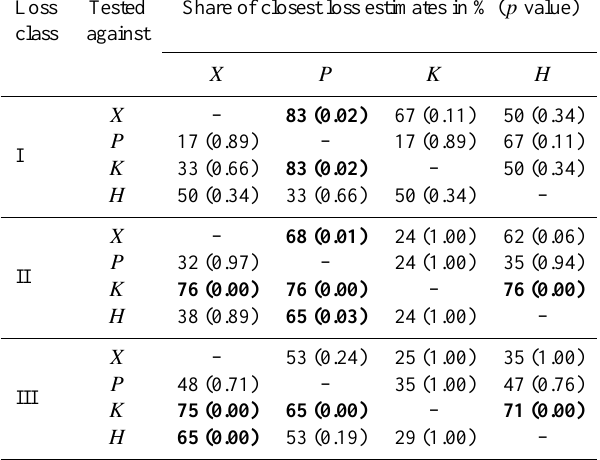
Table 3. Results from a binomial test for prediction accuracy of the different models based on daily loss estimates calculated from DWD wind gust data. The model of each column is tested against each row of competing models and across loss classes (as defined in Table 1). Bold results indicate superiority of the tested model with statistical significance greater than 95%.